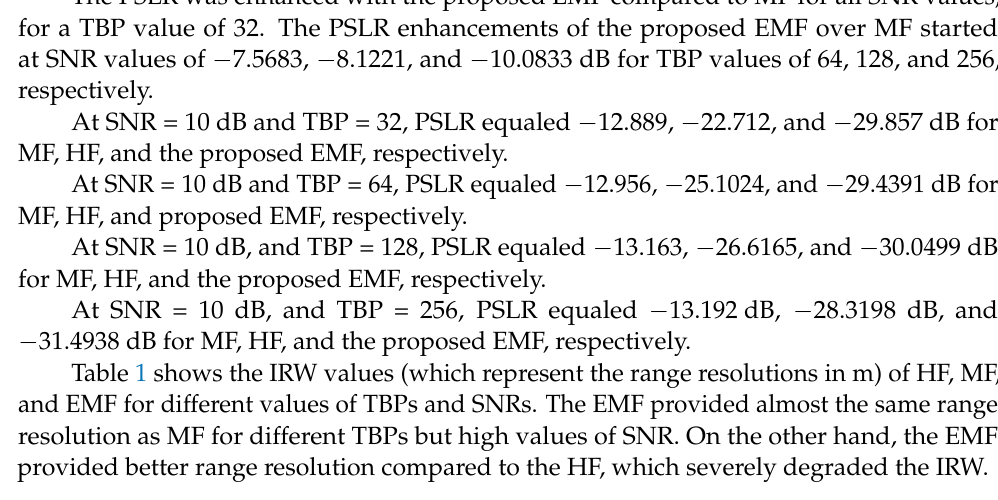
Figure 12. Peak sidelobe ratio (PSLR) versus SNR for MF, HF, and the proposed EMF: ( a ) TBP = 32, ( b ) TBP = 64, ( c ) TBP = 128, ( d ) TBP = 256. The PSLR was enhanced with the proposed EMF compared to MF for all SNR values, for a TBP value of 32. The PSLR enhancements of the proposed EMF over MF started at SNR values of − 7.5683, − 8.1221, and − 10.0833 dB for TBP values of 64, 128, and 256, respectively.